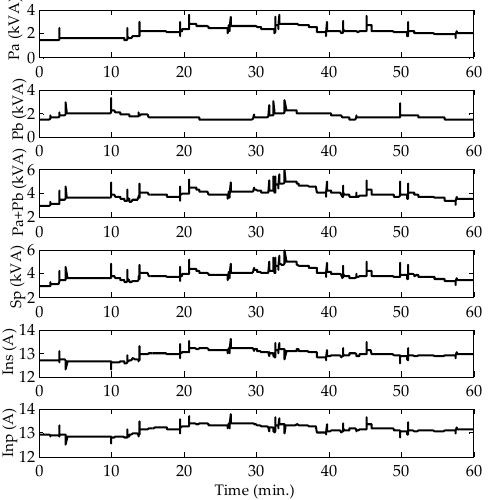
Figure 16. The powers and neutral currents of the transformer for the single-point neutral-broken condition.